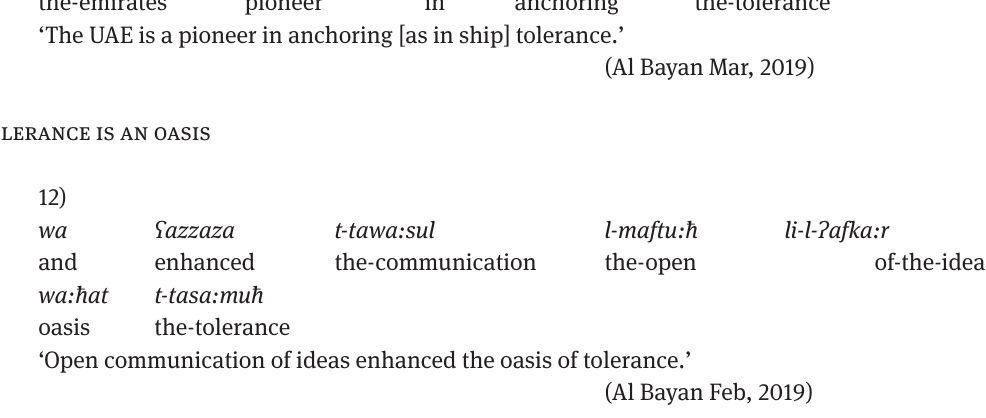
the-communication of-the-ideas oasis the-tolerance ‘Open communication of ideas enhanced the oasis of